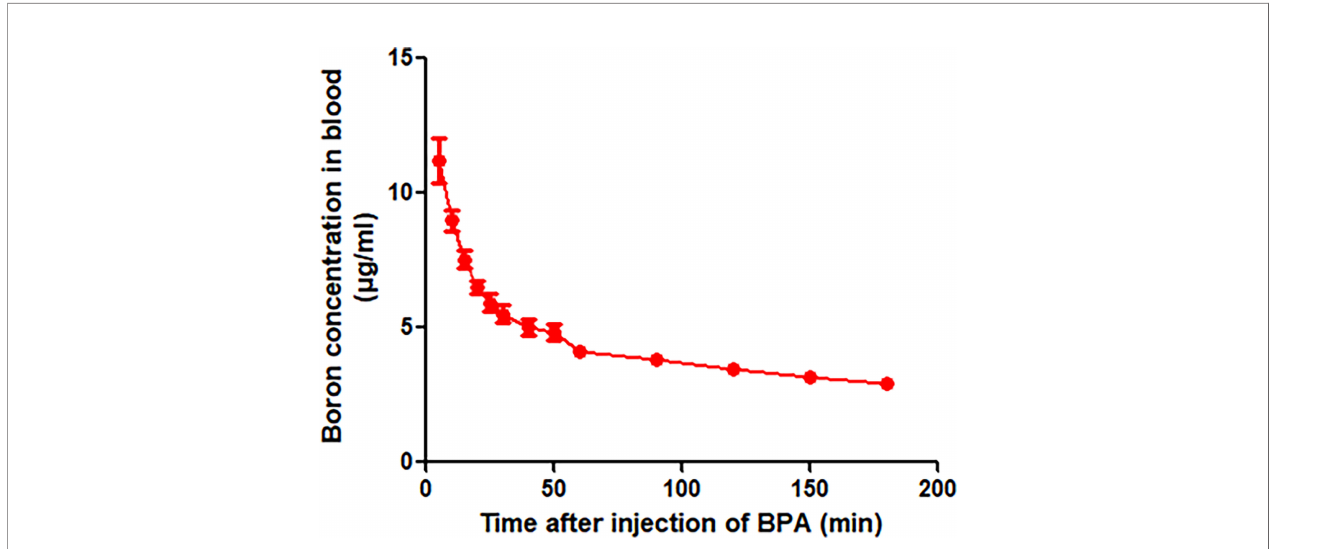
FIGURE 3 | Blood boron concentration – time curve of BPA in rats. Data were expressed as the means ± SD. N = 6. The dose of BPA was 125 mg/kg body weight. The age of male rats was 8 weeks. Blood was collected at 5, 10, 15, 20, 25, 30, 40, 50, 60, 90, 120, 150, and 180 min after BPA injection for boron